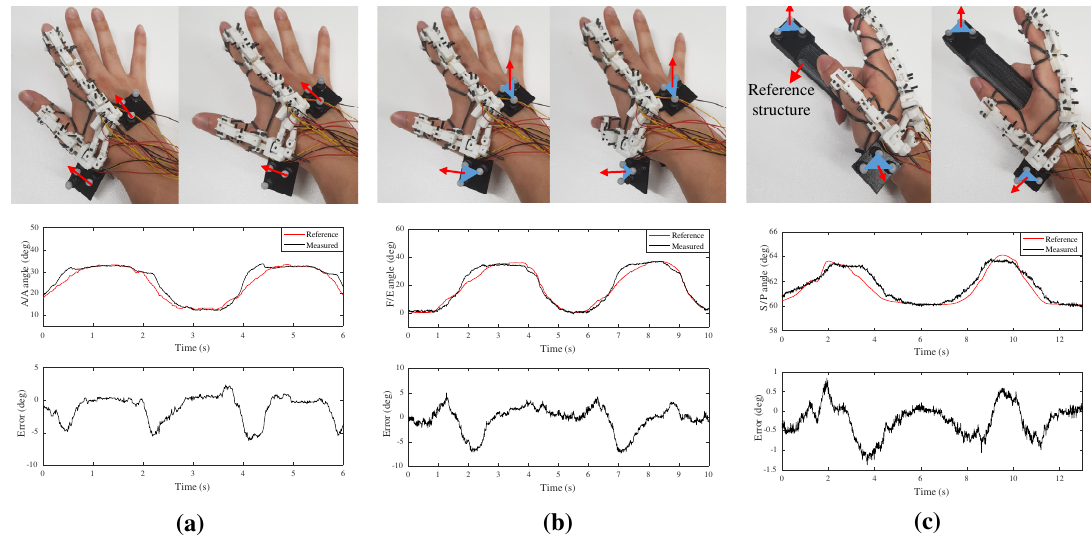
Figure 12. Experimental verification of CMC joint motion; ( a ) Ab/Ad motion of CMC joint; ( b ) F/E motion of CMC joint; ( c ) S/P motion of CMC